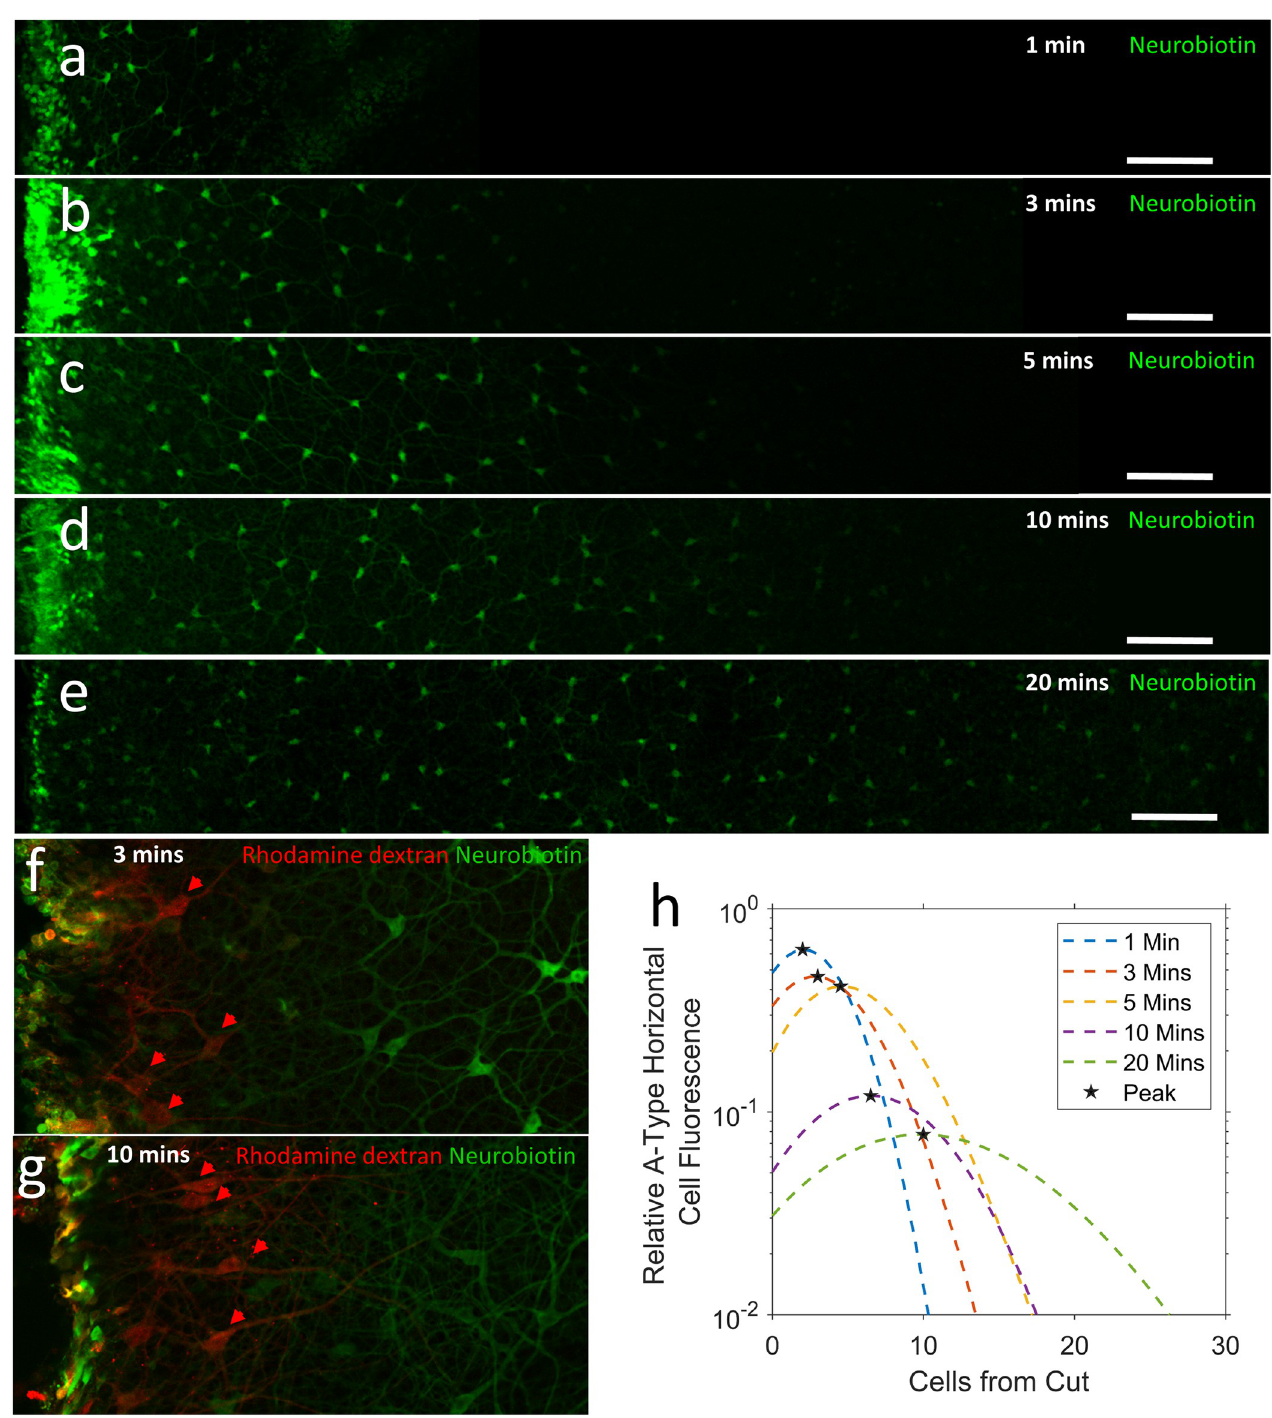
Fig 5. (a-e) The extent of dye-transfer through coupled a-type horizontal cells (aHCs) after different incubation times between 1 and 20 min. Images represent the average of 5, 1 μ m thick optical slices through the outer inner nuclear layer created using the z-project function in Fiji (see methods). The cut-edge is located on the left-hand side of each image. (f, g) aHCs cut-loaded with Neurobiotin (green) and the gap-junction impermeable dye Rhodamine dextran (red, aHCs identified with red arrows) after 3 and 10 min incubation respectively. (h) Relative mean cell fluorescence of aHCs per cell from the cut. Curves produced by fitting 3-paramenter polynomial fits to mean aHC data for each incubation time, fluorescence at the cut was excluded when creating the fit. The peak cell fluorescence for each curve is indicated by black stars. Scale bars signify 100 μ m.